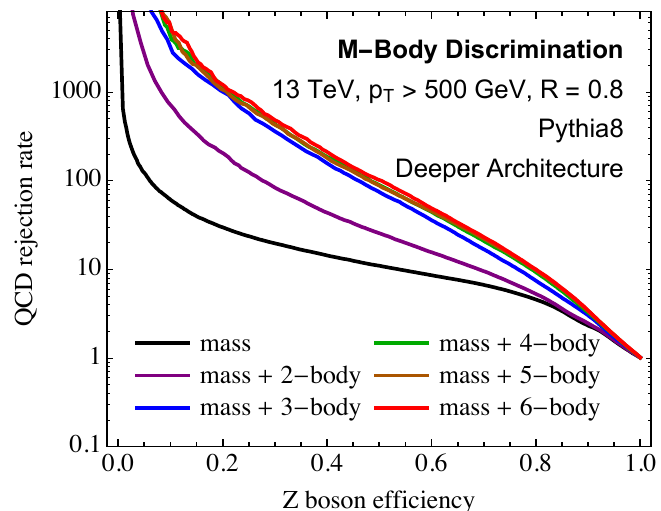
Figure 11. Z boson jet e(cid:14)ciency vs. QCD jet rejection rate plot as generated by the deeper neural network for events showered in Pythia. The di(cid:11)erent curves correspond to the mass plus collections of observables that uniquely de(cid:12)ne M -body phase space. Discrimination power is seen to saturate when 4-body phase space is resolved.